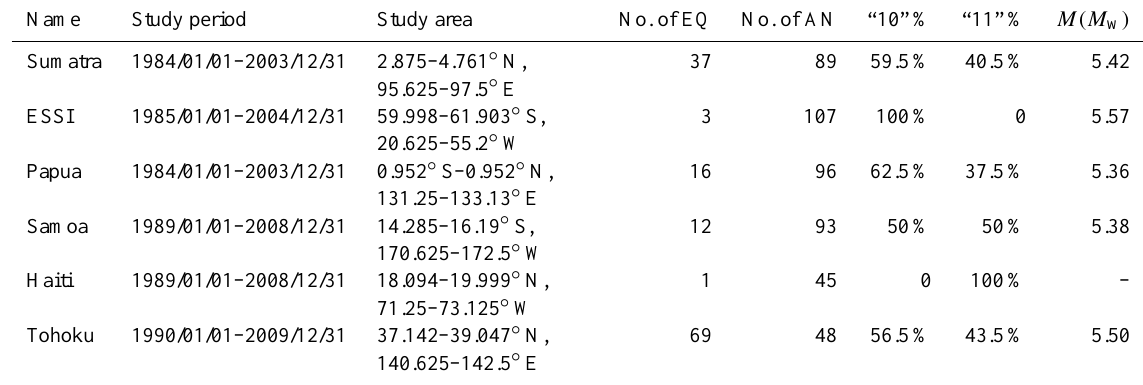
Table 6. Probabilities of “10” and